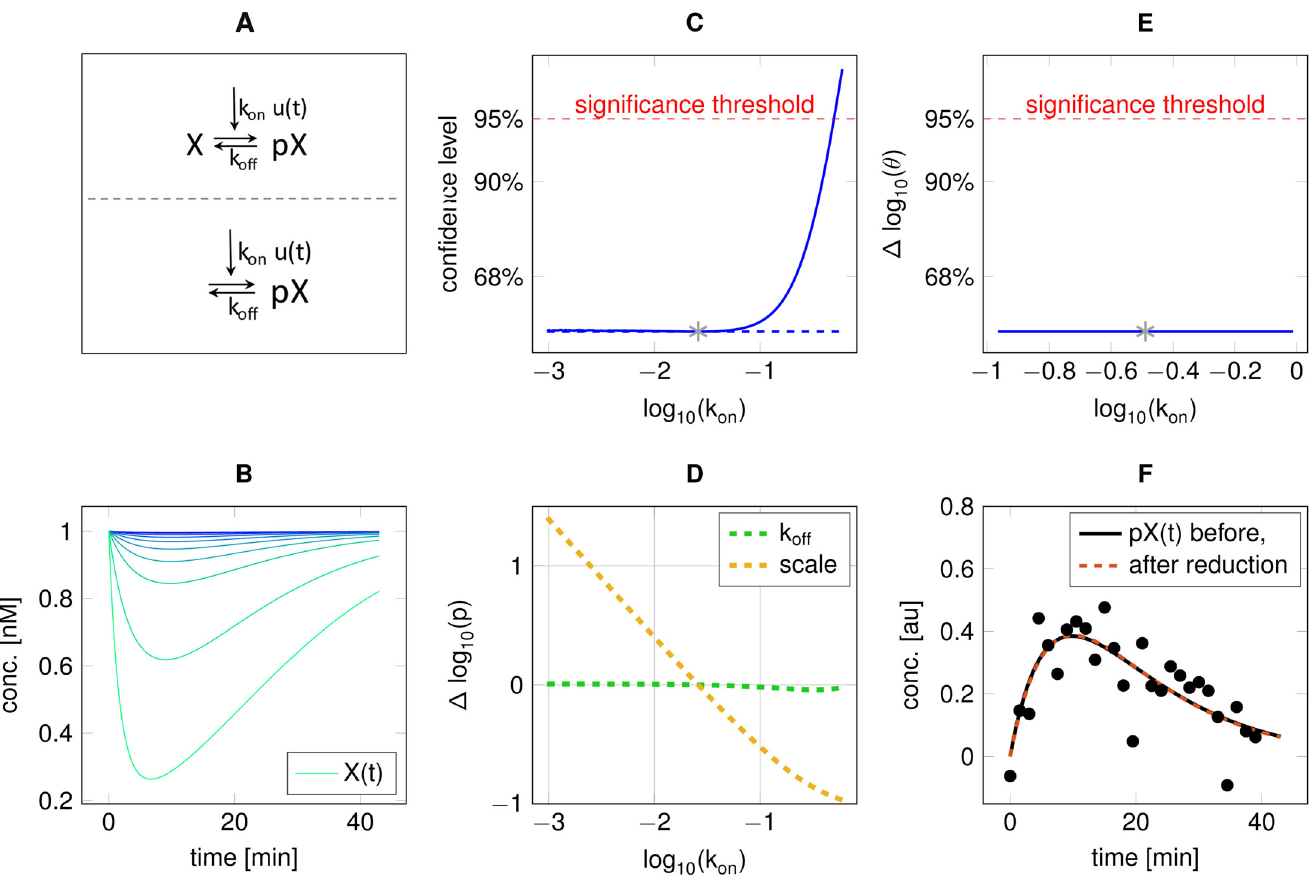
Fig 5. Model reduction of weakly activated signalling pathway (scenario 4). A: Model scheme before (upper) and after (lower) reduction. The difference is the omission of state X . B: X ( t ) for parameter sets along the profile likelihood of k on (high to low values of k on from bottom to top, i.e. cyan to blue). C: Parameter profile likelihood of k on , depicting a practical non-identifiability to small values. D: Relation of scale to k on . E: After model reduction, the parameter k on is structurally non-identifiable and can be set to an arbitrary value. F: Comparison of model fits before and after reduction. Both curves overlap and cannot be statistically distinguished based on the